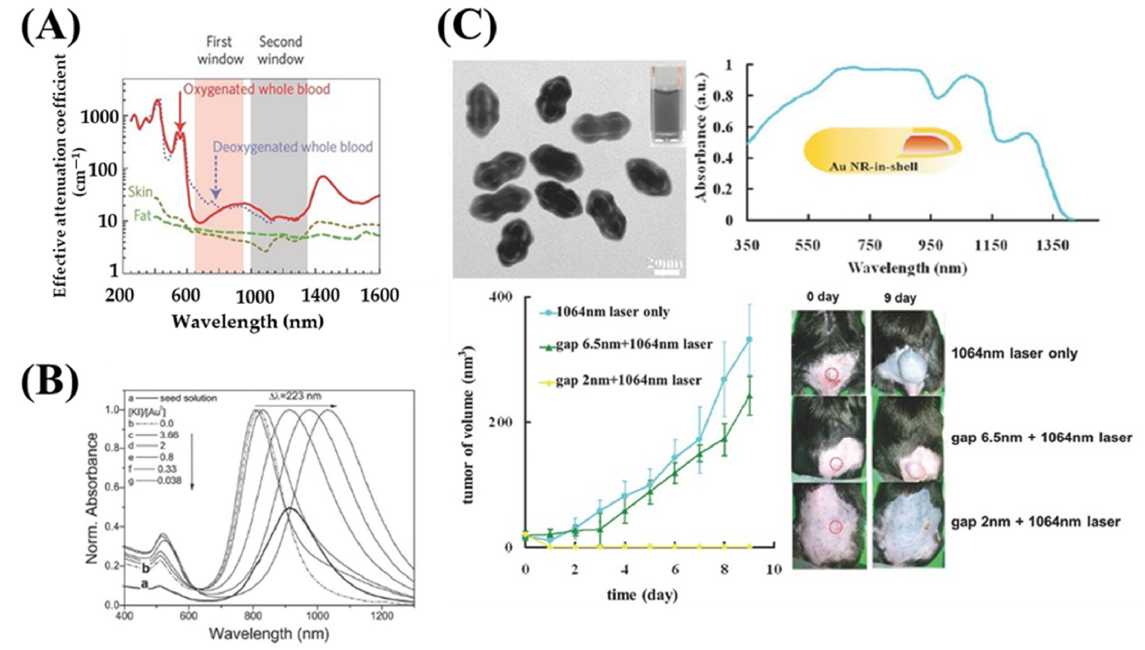
Figure 2. ( A ) Plot of the wavelength-dependent effective attenuation coefficient showing optical windows in biological tissues. ( B ) Representative examples of NIR–II–window–responsive plas- monic nanomaterials: AuNRs ( C ) Transmission electron microscopy (TEM) image and UV–visible– NIR spectrum of Au rod-in-shell nanostructures, and photographs showing the photothermal ther- apeutic effect. The red dotted circles indicate the location of the tumors. Figures from: ( A ) Adapted with permission [80]. John Wiley and Sons, Copyright 2017; ( B ) Adapted with permission [81]. John Wiley and Sons, Copyright 2008; ( C ) Adapted with permission [20]. American Chemical Society, Copyright 2013. 4. Development of Activatable NIR Photothermal Agents With the development of AuNPs mediated PTT in recent years, increasing effort has been devoted to solving two major defects. As mentioned above, many different strategies have become available to shift the working window into the NIR-II region, which has attracted substantial attention due to the higher maximum permissible exposure (e.g., 1064 nm, 1.0 W·cm − 2 ), lower biology background, and deeper penetration depth versus the NIR-I region. On the other hand, the therapeutic specificity of AuNPs mediated PTT depends on the specific delivery of gold nanomaterials and NIR laser irradiation to tu- mors, and most photothermal agents with “always on” mode suffer from inherent non- specificity and undesirable treatment-related side effects. In contrast, the design of acti- vatable or smart photothermal agents offers an innovative approach to interact with tar- gets of interest, allowing for the precise and effective suppression of cancer without side effects. These stimulus-responsive agents use the unique characteristics of the tumor mi- croenvironment, including mild acidic nature, disordered redox potentials and hypoxia, as well as the overexpressed specific enzymes, to achieve “off” to “on” switching tumor- specific detection and therapy (Figure 3). For instance, Kim et al. reported a pH-responsive AuNPs that can agglomerate at the tumorous site and elicit a significant absorption wave- length shift into the NIR optical window to spare normal cells and minimize unwanted damage [82]. Other gold-based pH-responsive photothermal agents are reported by both Liu’s and Wong’s groups [83,84]. These nanoagents could intelligently respond to the tu-